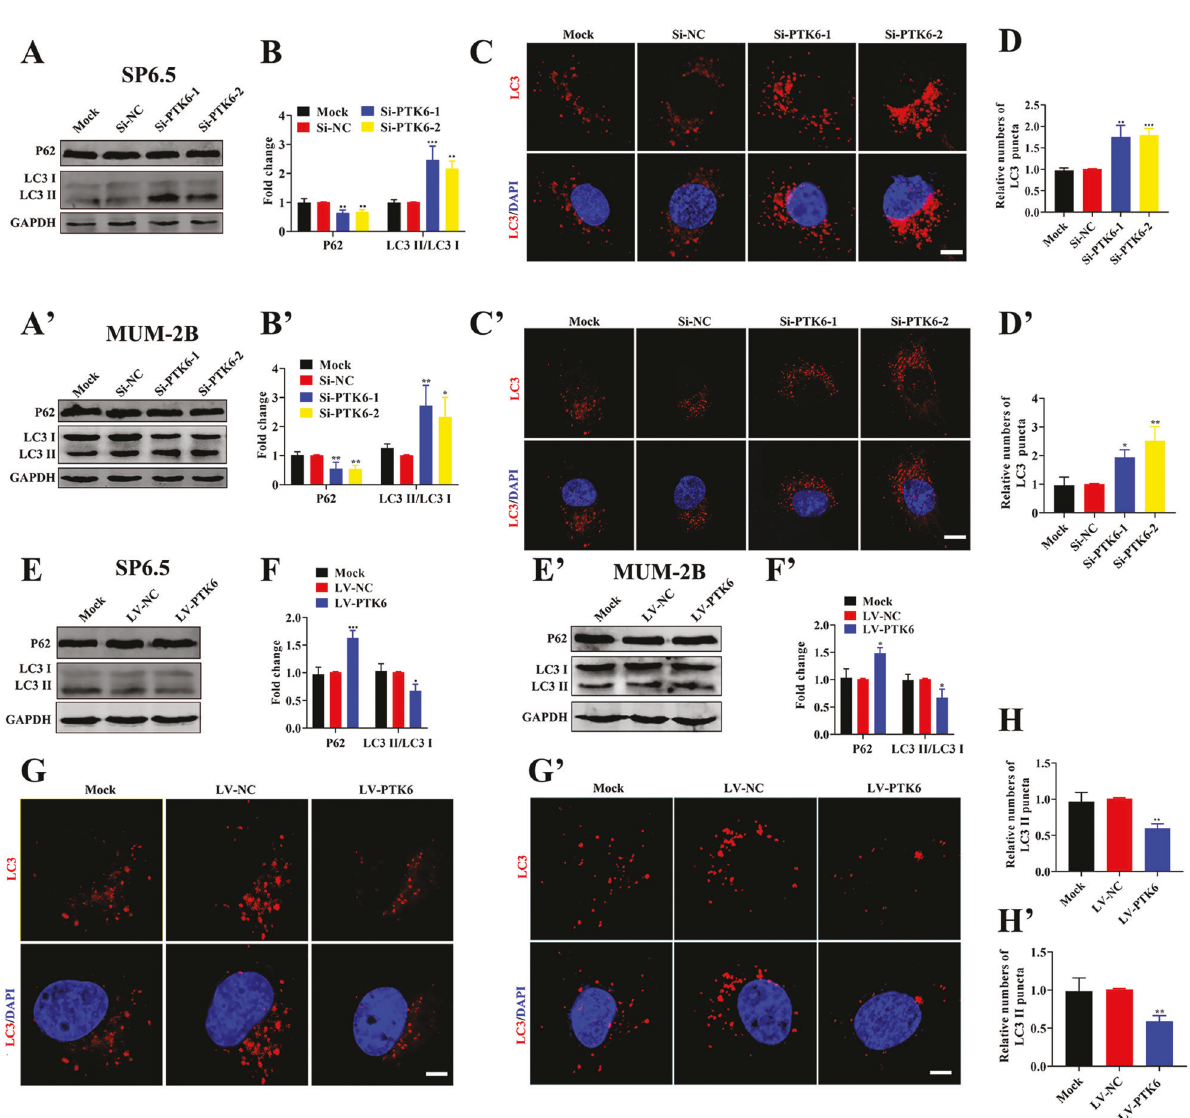
Fig. 3 PTK6 inhibits autophagy in UM cells. A , B and A ’ , B ’ Western blotting analysis of LC3 and P62 in UM cells with PTK6 knockdown. C , D and C ’ , D ’ Immuno fl uorescence analysis of autophagosomes in UM cells with PTK6 knockdown. The above data were analyzed using one-way ANOVA with Bonferroni. E , F and E ’ , F ’ Western blotting analysis of LC3 and P62 in UM cells overexpressing PTK6. G , H and G ’ , H ’ Immuno fl uorescence analysis of autophagosomes in UM cells overexpressing PTK6. The above data were analyzed using one-way ANOVA with Bonferroni. (A-H: SP6.5 cell; A ’– H ’ : MUM-2B cell; scale bar: 20 µm; Data were presented as the mean ± SD; n = 3; * p < 0.05, ** p < 0.01, *** p < 0.001). SOCS3 binds to PTK6 and inhibits PTK6 expression treated with rapamycin were decreased compared with those of PTK6 is a tyrosine kinase, which consists of three protein domains the LV-PTK6 group and the LV-NC group treated with DMSO. (a classic src homology 3 (SH3) domains, a src homology 2 (SH2) Based on the above data, we concluded that PTK6 promotes UM domain, and a tyrosine kinase (SH1) domain). The protein domains tumorigenesis by inhibiting autophagy. Cell Death and Disease (2023)